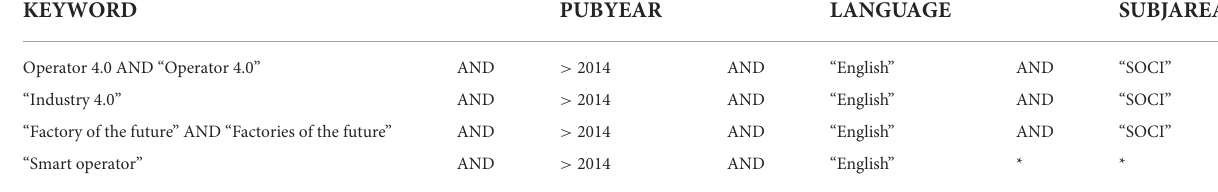
TABLE 1 Keywords and filters used in the research.